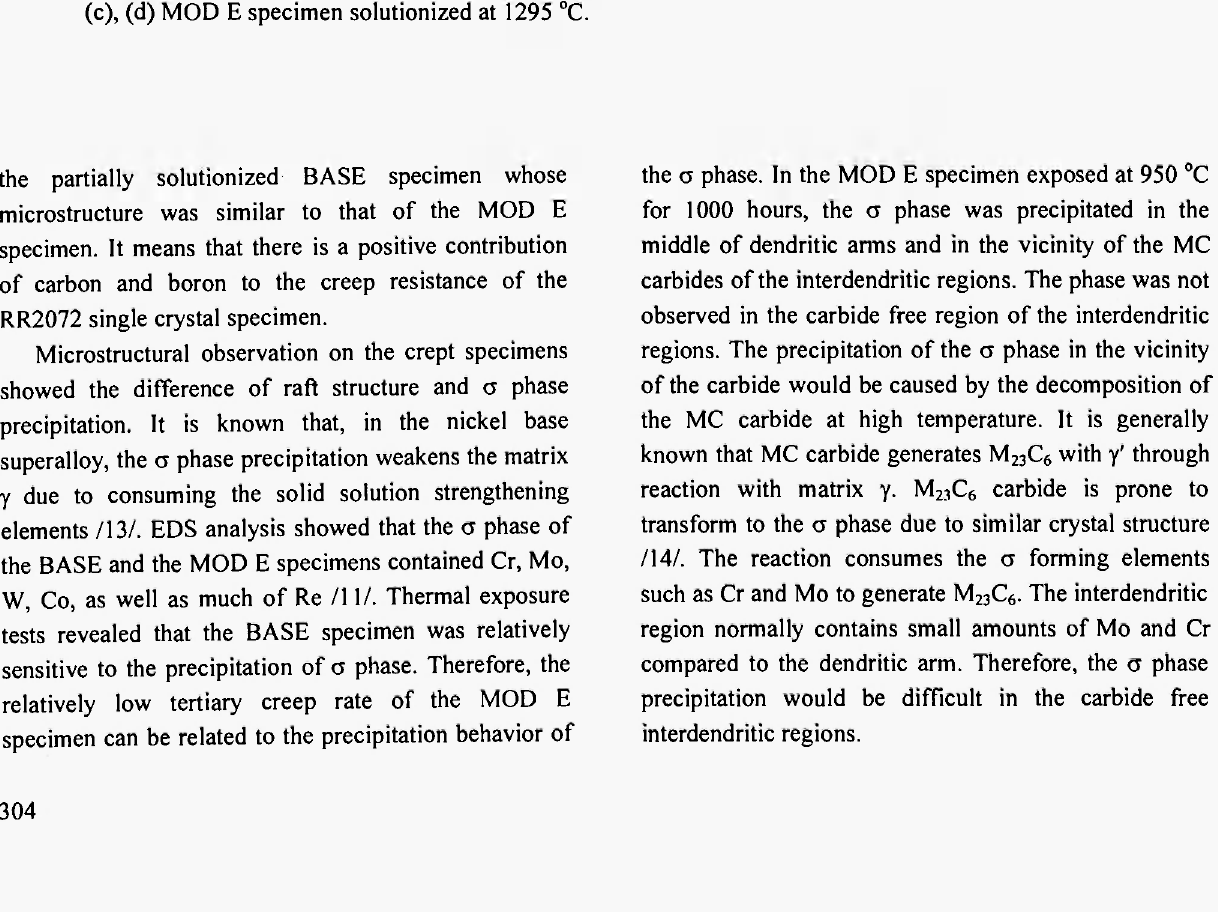
Fig. 6: Micrographs of interdendritic region of exposed single crystals. Left column was exposed at 950 °C / 100 hours, and right column was exposed at 1050 °C /100 hours, (a), (b) BASE specimen partially solutionized at 1295 °C, (c), (d) MOD Ε specimen solutionized at 1295